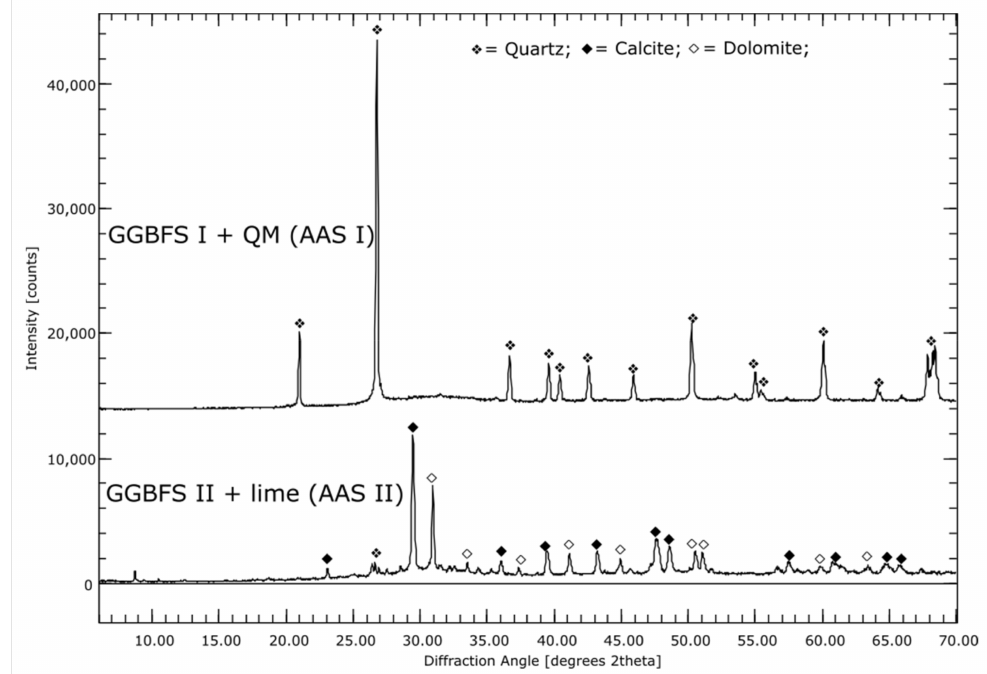
Figure A5. Graphical representation of XRD measurements: